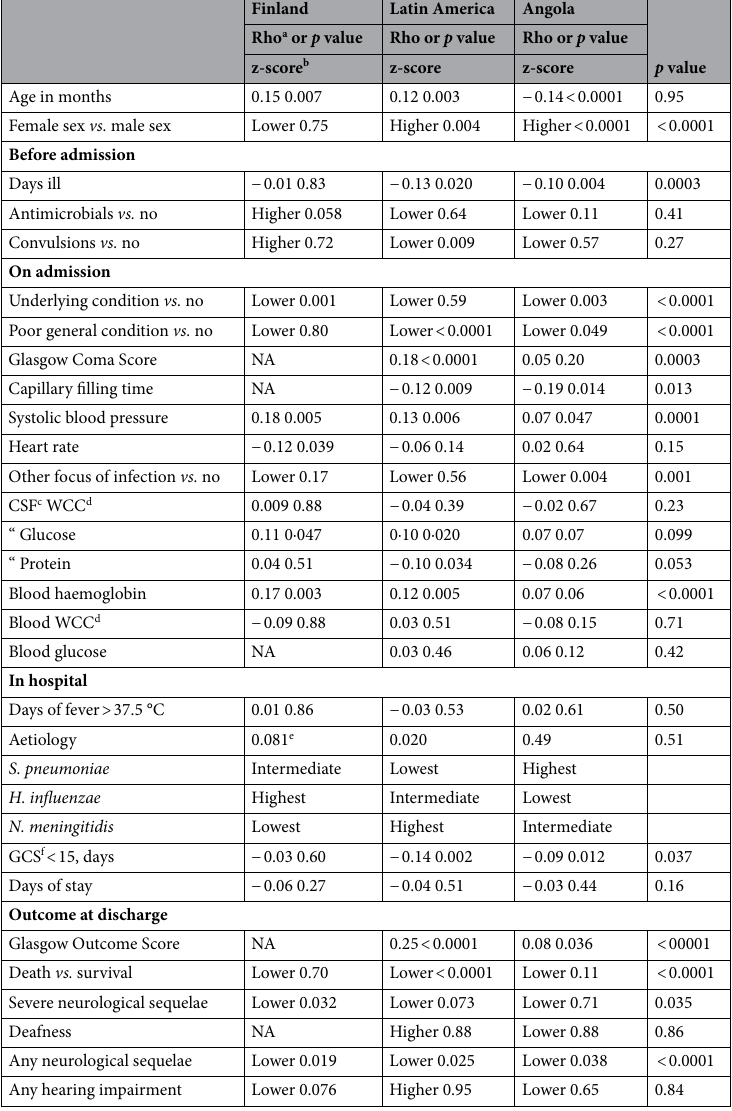
Table 2. Associations between weight-for-age z-score and other findings in children with bacterial meningitis from Finland, Latin America, and Angola. a By Spearman correlation. b Whether the z-score mean value in patients with the indicated variable was higher or lower vs. patients without it, as analyzed by Student´s t-test., c Cerebrospinal fluid. d White cell count. e by ANOVA. f Glasgow Coma